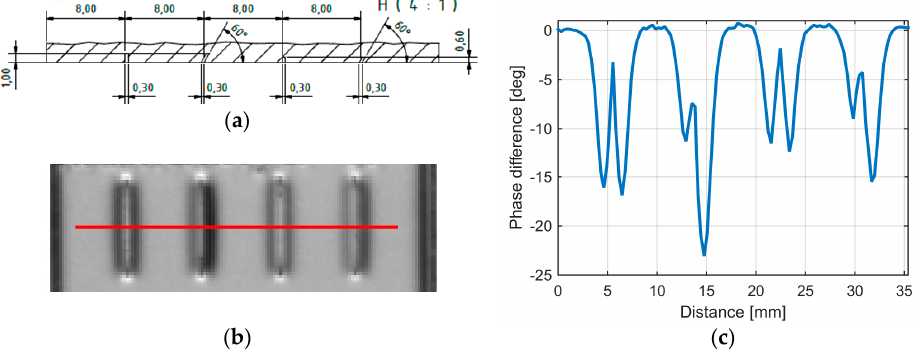
Figure 16. ( a ) CAD data for four artificially created cracks in a laser-sintered sample; ( b ) phase image after a 0.1 s heating pulse; ( c ) profile through the phase image at the red marked position.